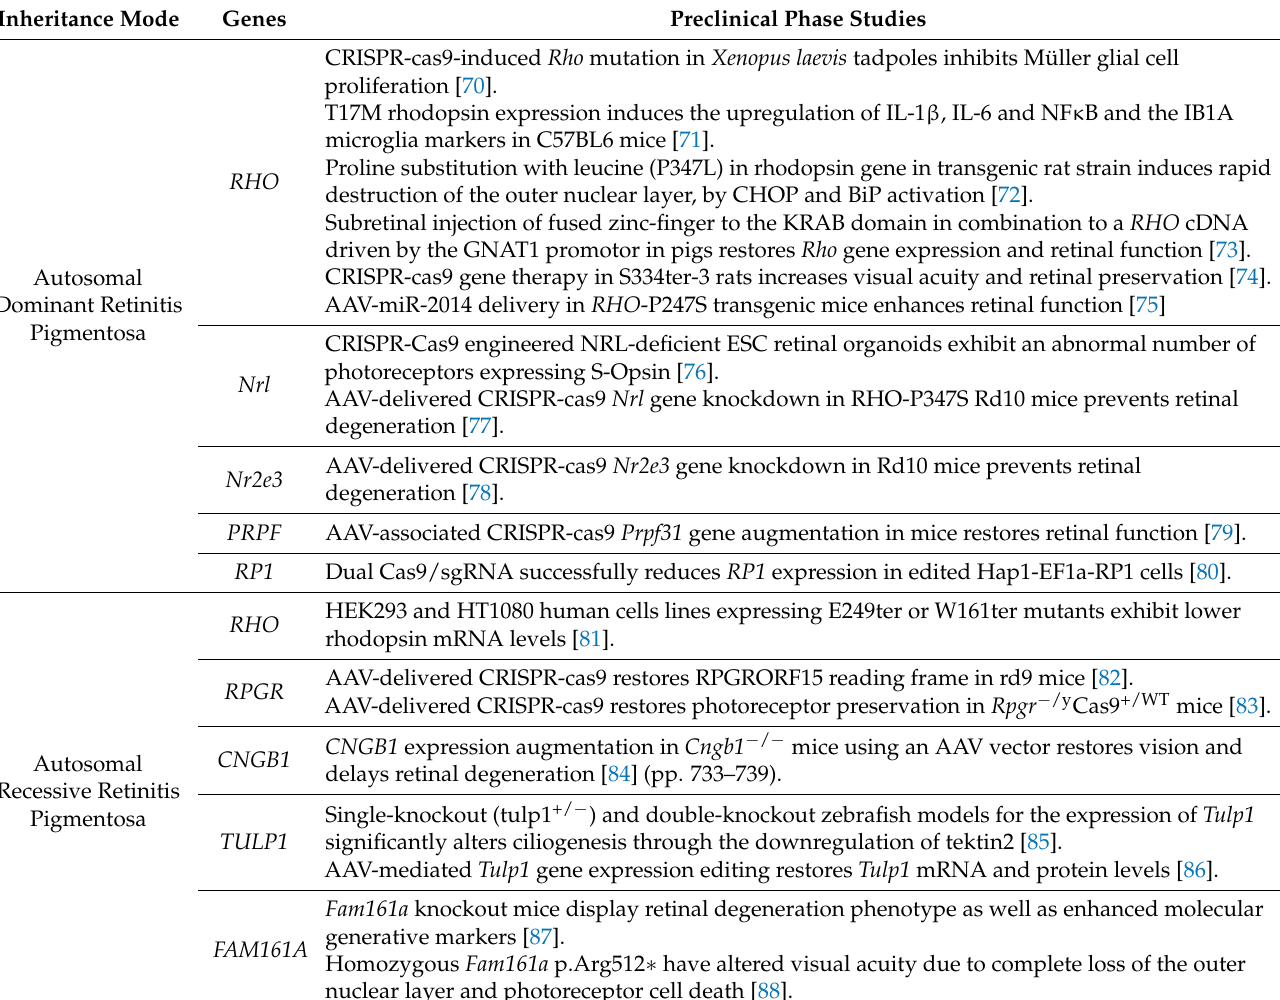
Table 1. Summary of preclinical phase study advances for retinitis pigmentosa-related gene mutations. This table summarizes the new advances in preclinical phase studies that target retinitis pigmentosa- related gene